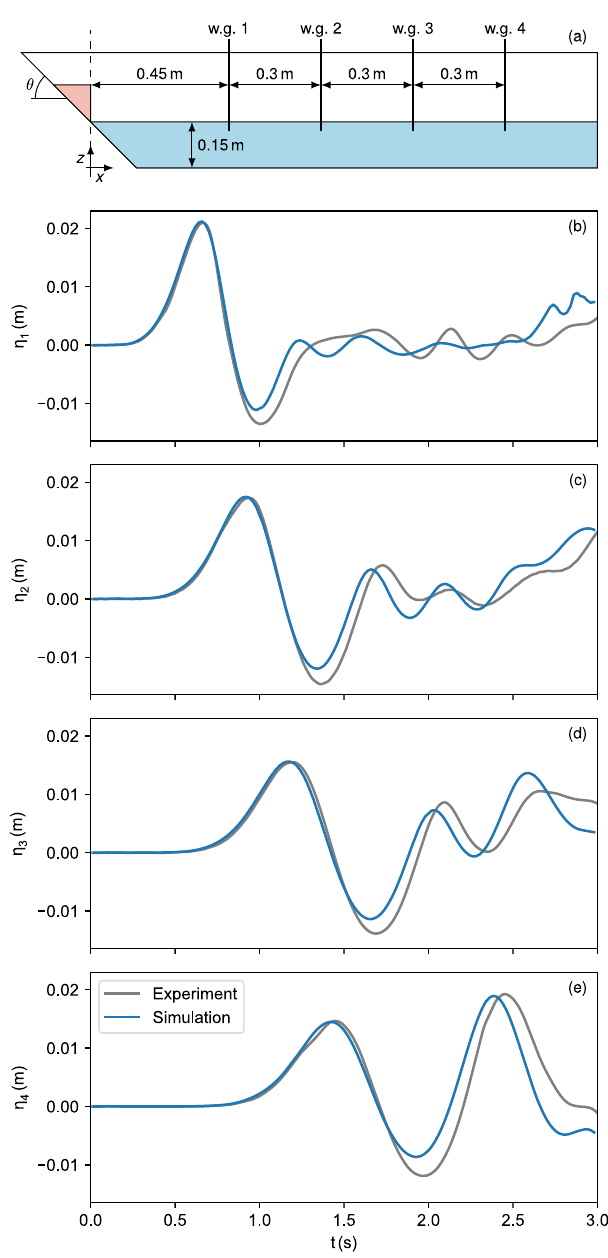
Fig. 4 Wave signal in the small-scale model. a The simulation setup with the position of the wave gauges (w.g.) at x = 0.45, 0.75, 1.05, 1.35 m. The slope angle θ is 45 ∘ in the presented case. b – e Water elevation over time at the four wave gauges in the simulation and the experiment. Note that there is some freedom concerning the de fi nition of t = 0, i.e. the synchronisation between simulation and experiment. Here t = 0 is the time at which the gate is opened